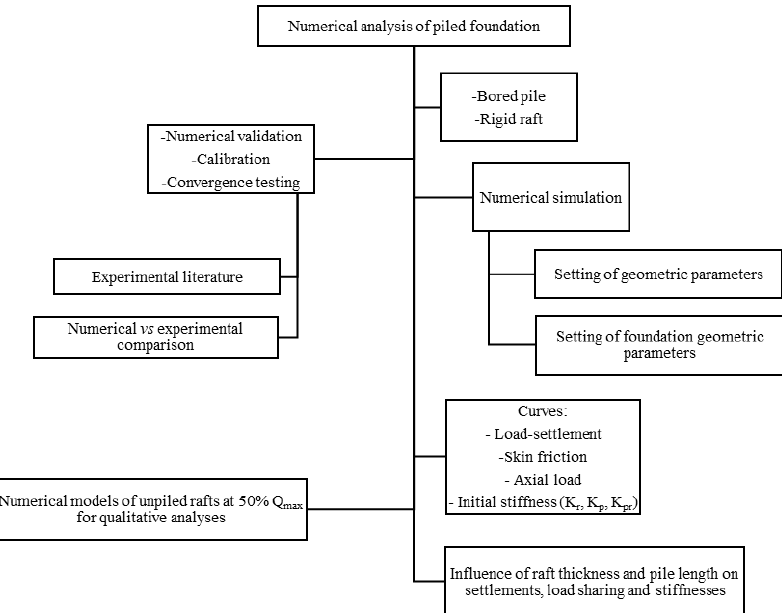
Figure 7. Scheme describing the steps of the present study.